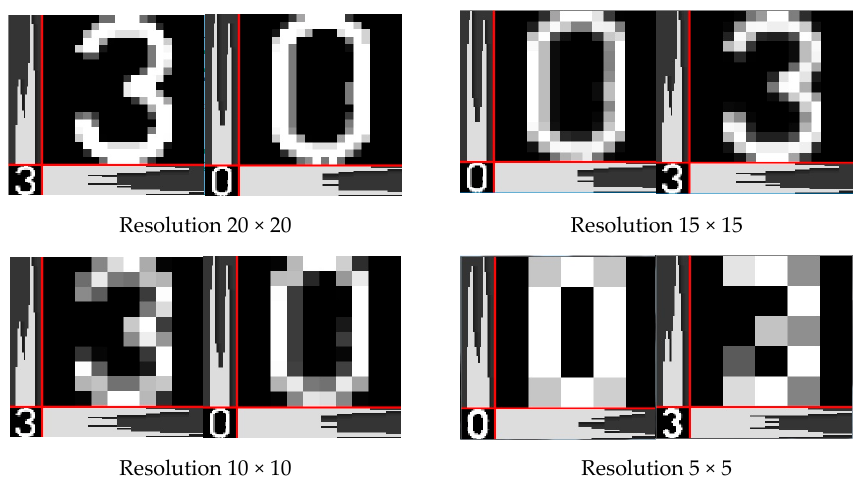
Figure 14. Three feature quantities at each resolution for the extracted number 30.